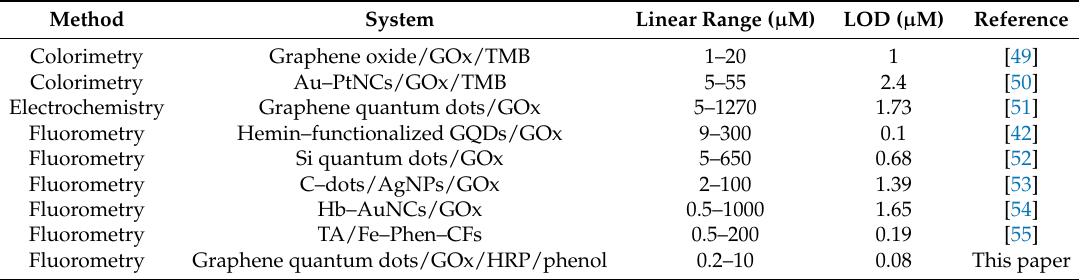
Figure 6. Fluorescence emission spectra of different concentrations of glucose. 0 (black), 0.2 (red), 1.0 (green), 2.0 (blue), 4.0 (cyan), 6.0 (magenta), 9.0 (yellow), 10 (dark yellow) µ mol/L, respectively. Inset is the linear calibration of the fluorescence intensity ratio of I/I 0 and the concentration of glucose. Table 1. Comparison of different methods for the determination of